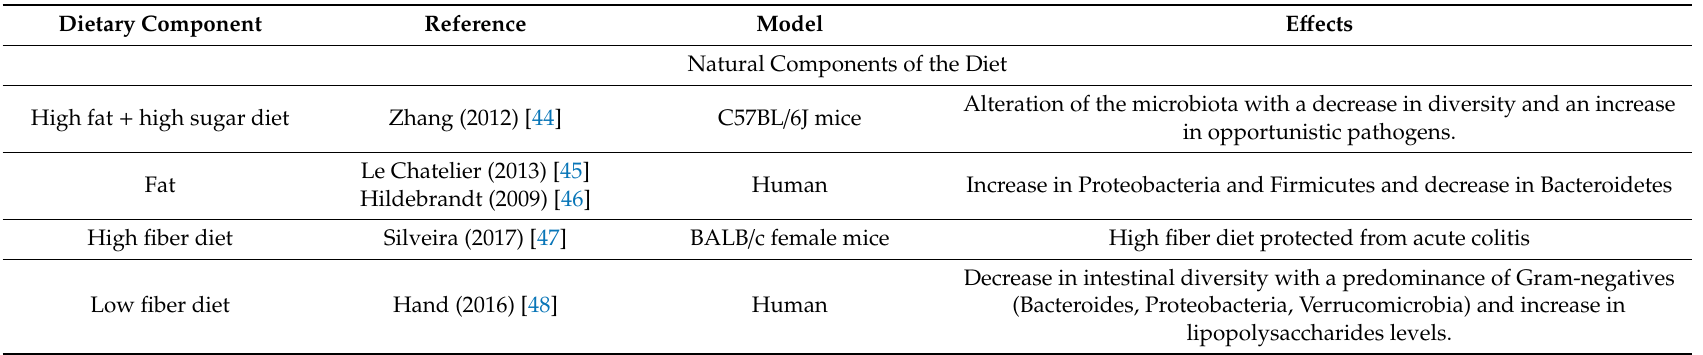
Table 2. Dietary factors that potentially a ff ect to microbiome (Updated from reference